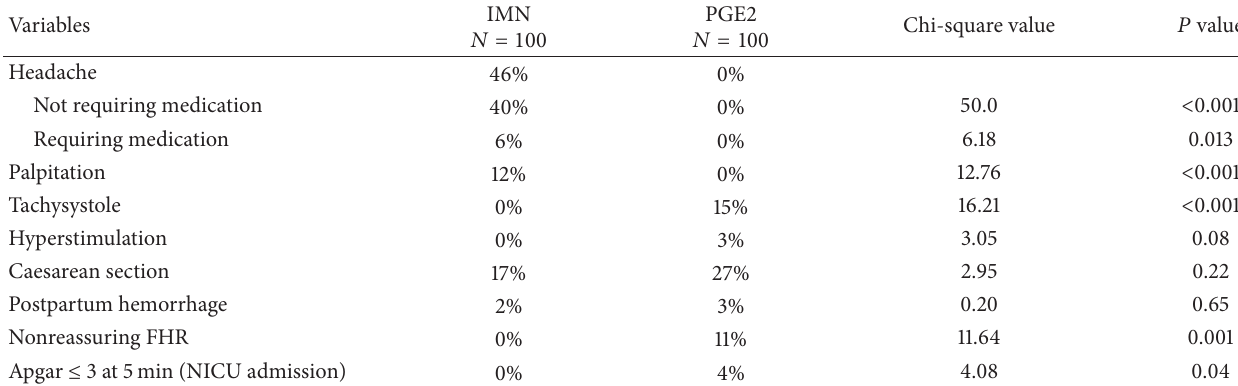
Table 4: Maternal and fetal outcome.